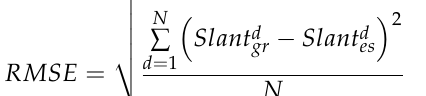
Figure 7. Application of our slant removal technique on a sample from the George Washington DB ( left ); corrected by −42.5° ( right ). 3.3. BH2M DB The BH2M database [20] has been created under the EU ERC project Five Centuries of Marriages (5CofM). It includes the Archives of the Barcelona Cathedral: 244 books with information on approximately 550,000 marriages held between 1451 and 1905 in over 250 parishes. Each book was written by a different writer and contains information of the marriages during two years. Here pages for the 6th book are used. In Figure 8, an example of the BH2M DB is presented.